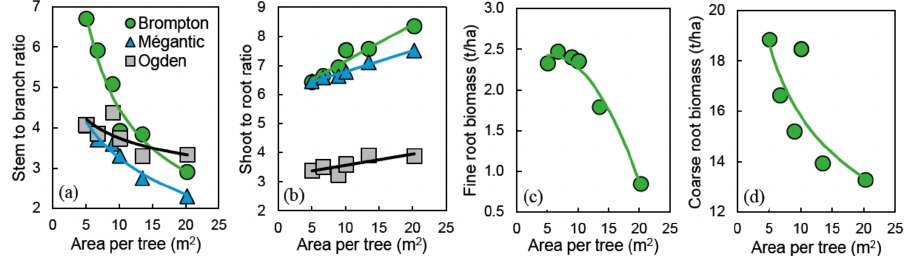
Figure 3. Site-specific relationships between the area per tree at planting and ( a ) the stem to branch biomass ratio at the stand-level, ( b ) the shoot to root biomass ratio at the stand-level, ( c ) fine root biomass and ( d ) coarse root biomass in 14 year-old hybrid plantations. Only relationships with p < 0.1 are presented. Model type, fit and significance level of the relationships are the following for panel ( a ): Brompton site (power model, R 2 = 0.95, p < 0.001), Mégantic site (logarithmic model, R 2 = 0.97, p < 0.001), Ogden site (power model, R 2 = 0.56, p = 0.09); for panel ( b ): Brompton site (linear model, R 2 = 0.94, p < 0.01), M é gantic site (linear model, R 2 = 0.98, p < 0.001), Ogden site (linear model, R 2 = 0.61, p = 0.07); for panel ( c ): Brompton site (polynomial model, R 2 = 0.97, p < 0.01). The shoot to root ratio exclude fine root biomass; for panel ( d ): Brompton site (power model, R 2 = 0.68, p <